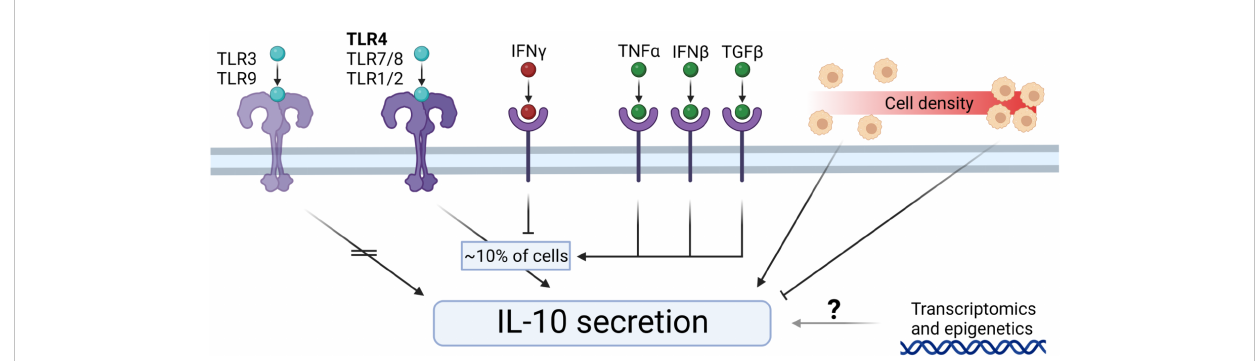
FIGURE 7 Extracellular control of IL-10 secretion by macrophages. TLR3 and TLR9 stimulation does not induce IL-10 secretion. TLR4, TLR7/8, and TLR1/2 initiates IL-10 secretion by a percentage of cells. IFN g downregulates the fraction of IL-10 producers. TNF a , IFN b , and TGF b upregulate the fraction of IL-10 producers. Cell density regulates IL-10 secretion dynamics, where low-density results in relatively more IL-10 production, and high-density results in relatively less IL-10 production. The exact role of transcriptomics and epigenetics on the IL-10 secretion remains